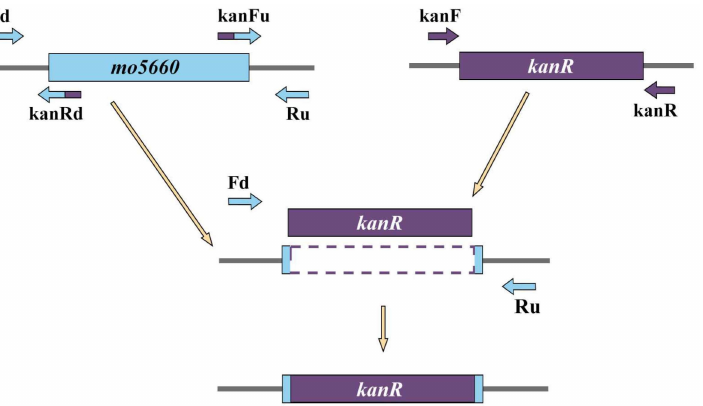
Figure 2. Construction of mo5660 knock-out mutant by gene replacement. First step: Upstream and downstream regions of mo5660 were amplified independently along with the kanamycin resistance cassette ( kanR ) which was amplified from pKD4 plasmid with primers KanF and KanR. The 3 (cid:48) end of kanRd and kanFu primers had forty nucleotides homologous to mo5660 while the 5 (cid:48) end had twenty nucleotides homologous to kanR . Second step: PCR products obtained from the first step were mixed together in equal concentration, amplified with primers Fd and Ru to generate the ∆ mo5660